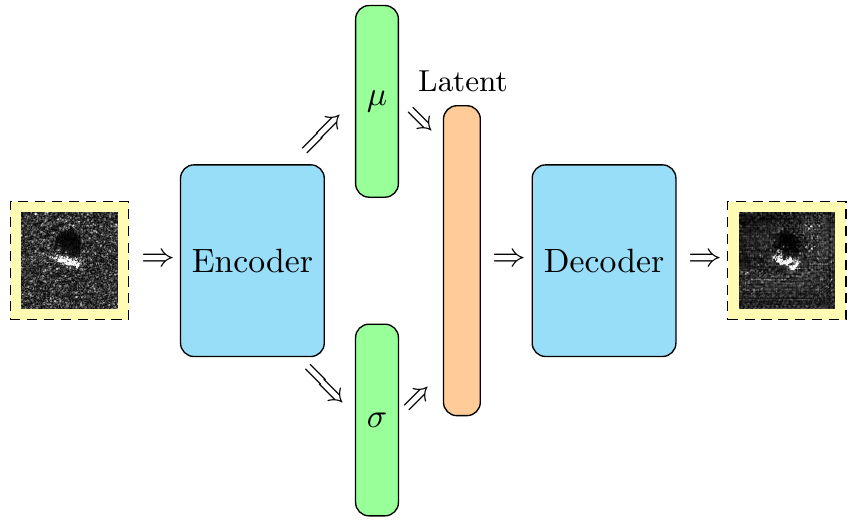
Figure 6. The schematic diagram of